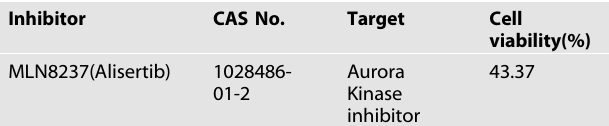
Table 4. Information of Alisertib in drug